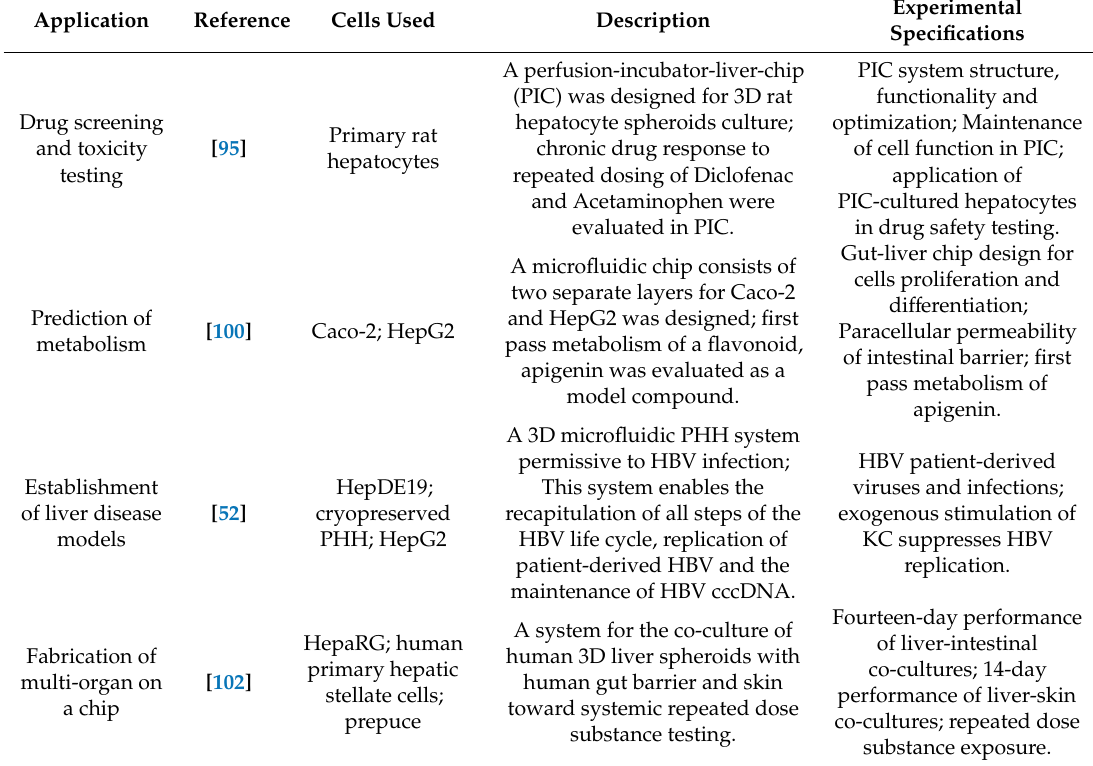
Table 5. Typical applications of liver-on-a-chip